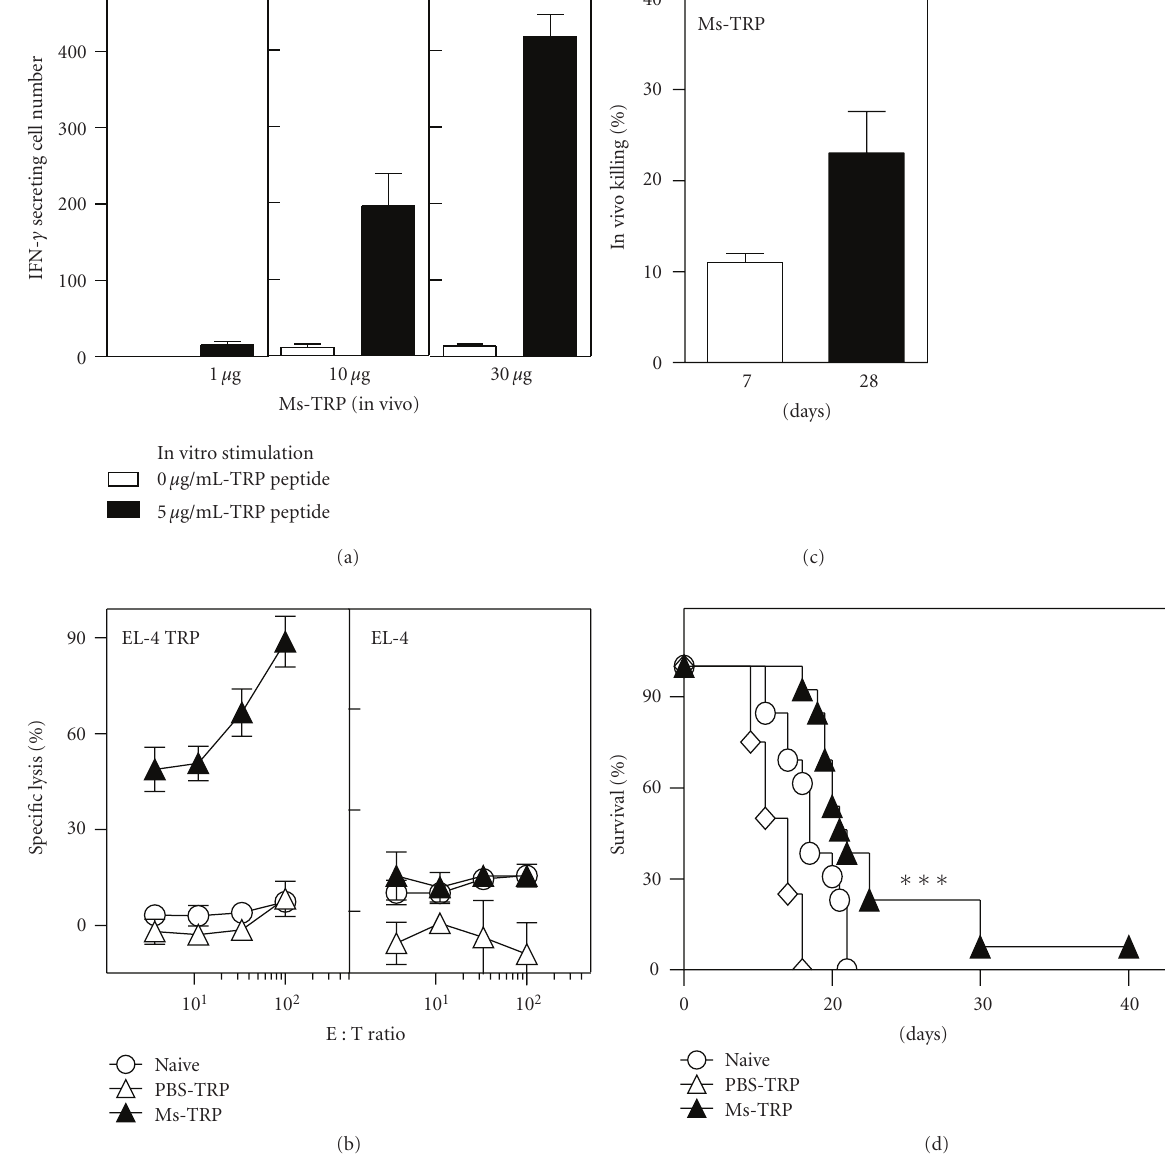
Figure 3: CD8 + T cell response and tumor protection induced by Ms-TRP vaccine. C57BL/6J mice were immunized in (a) with 1, 10, or 30 μ g TRP peptide entrapped in Ms archaeosomes on days 0 and 21. At 5 weeks, representative mice ( n = 2 per group) were euthanized, the spleen cells were stimulated with IL-2 (0.1ng/mL) and peptide (5 μ g/mL) for 48h, and the frequency of IFN-gamma secreting cells was enumerated